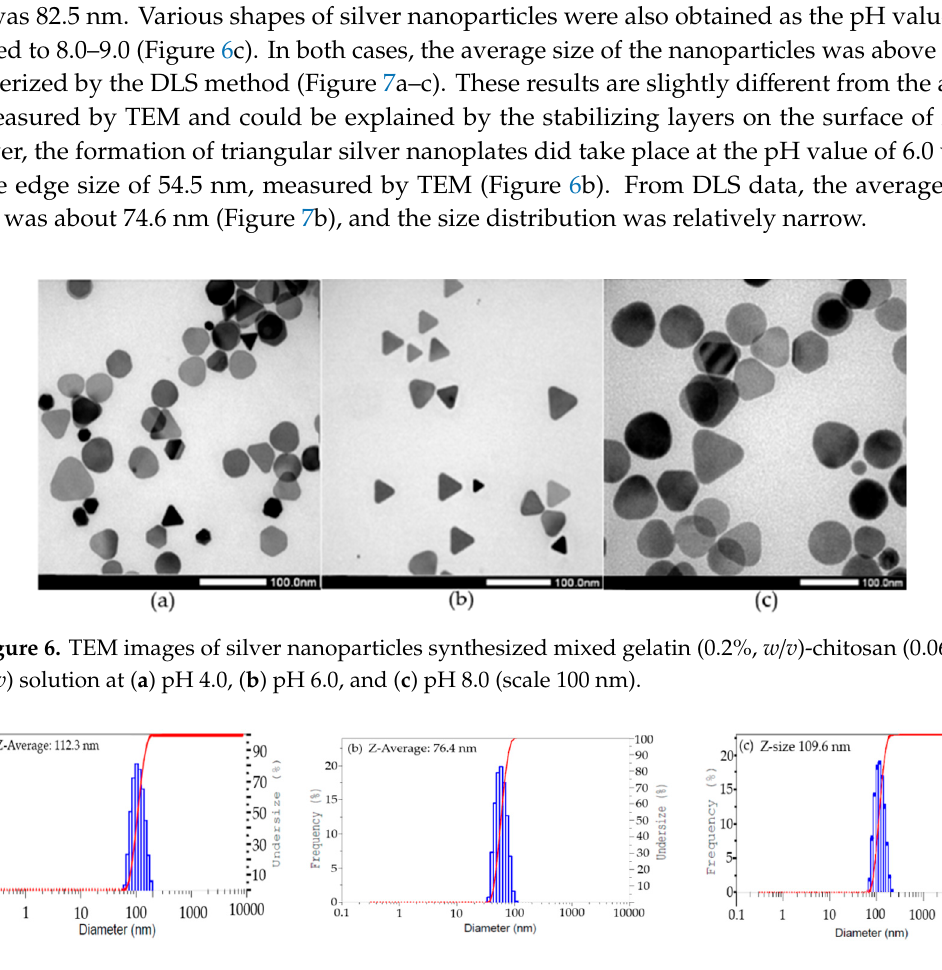
Processes 2019 , 7 , x FOR PEER REVIEW